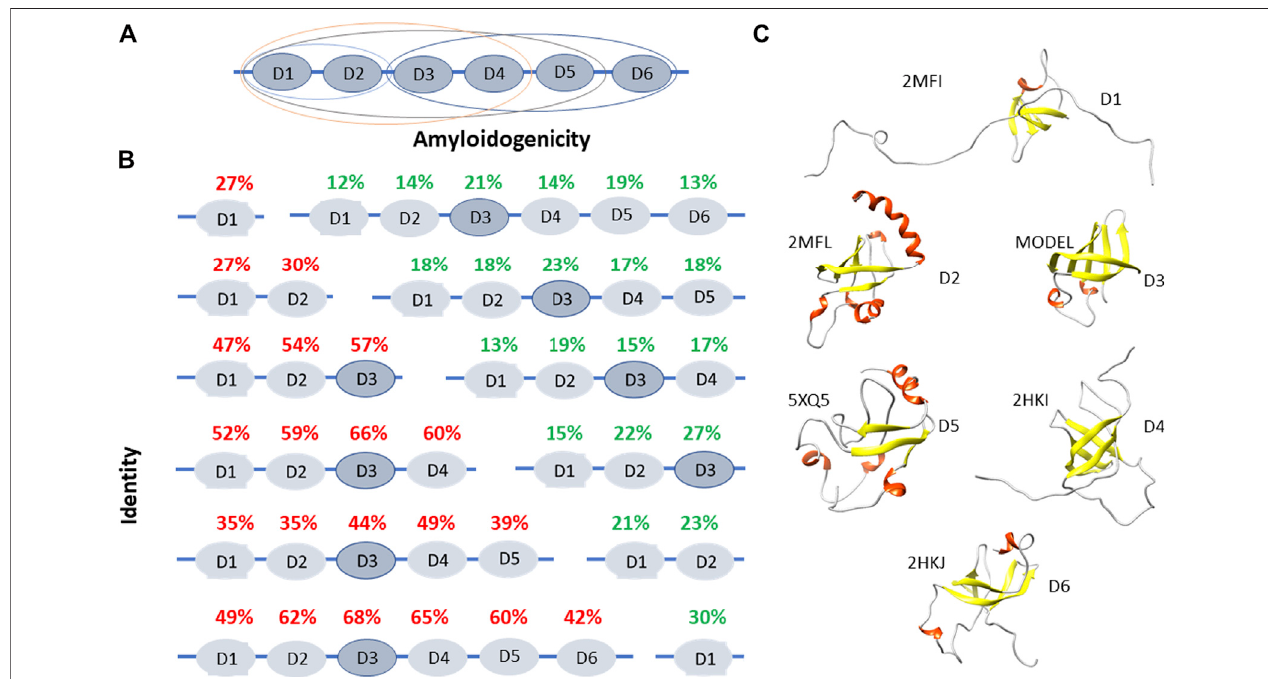
FIGURE 1 | Structural and functional features of ribosomal S1 protein. (A) The domain and functional organization of the S1 protein from E. coli are marked with different ovals. D1-D2 domains interact with the 30 S ribosomal subunit, D3-D6 domains interact with RNA (Suryanarayana and Subramanian, 1979; Subramanian, 1983). D1-D4 domains interact with the 30 S subunit, are involved in the initiation and translation of synthetic mRNA (poly (U) (Subramanian, 1985). D3 domain is of fundamental importance when interacting with mRNA and tmRNA. It is also important when interacting with ribonuclease regB (McGinness and Sauer, 2004). (B) Identity and amyloidogenicity of the 1,453 sequences of ribosomal S1 proteins from 25 different phyla. (C) Spatial structures from the Protein Data Bank for D1, D2, D4, D5, and D6 domains of ribosomal S1 protein from E. coli . Structure for D3 was predicted using the Robetta